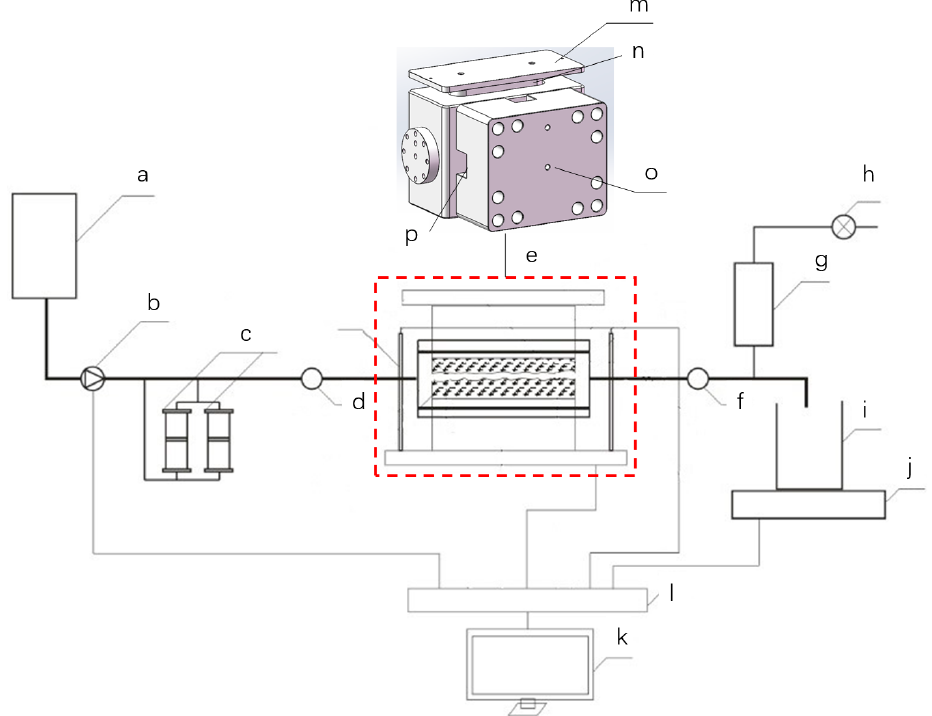
Figure 2. Schematic of the experimental apparatus: (a) upstream fluid reservoir, (b) pump, (c) pre- treated fracturing fluid reservoir, (d) pressure transducer, (e) conductivity cell, (f) back pressure regulator, (g) vacuum buffer container, (h) vacuum pump, (i) downstream fluid collection container, (j) precision lab scale, (k) computer, (l) data acquisition panel, (m) hydraulic load frame, (n) vertical- direction piston, (o) lateral load frame, and (p) side